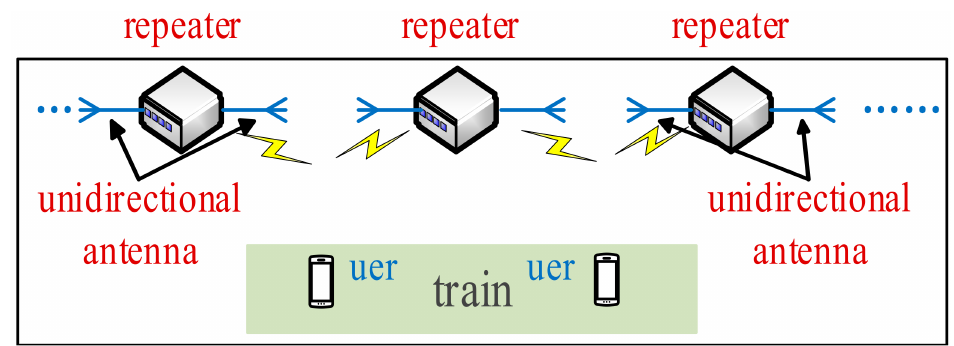
Figure 2. Antenna